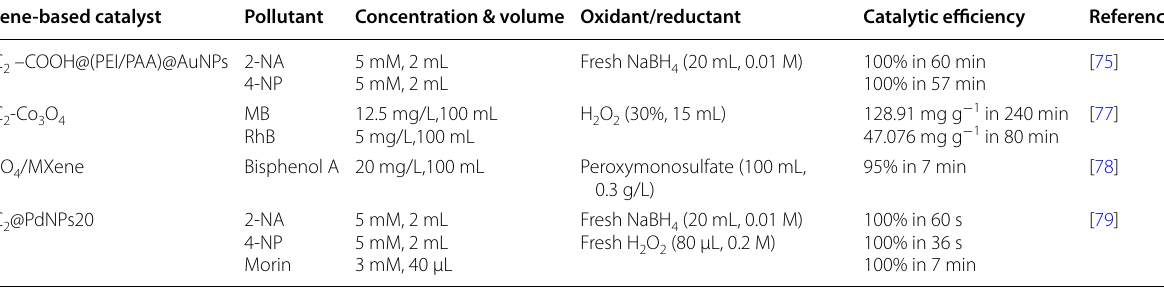
2-NA nitroaniline, 4-NP